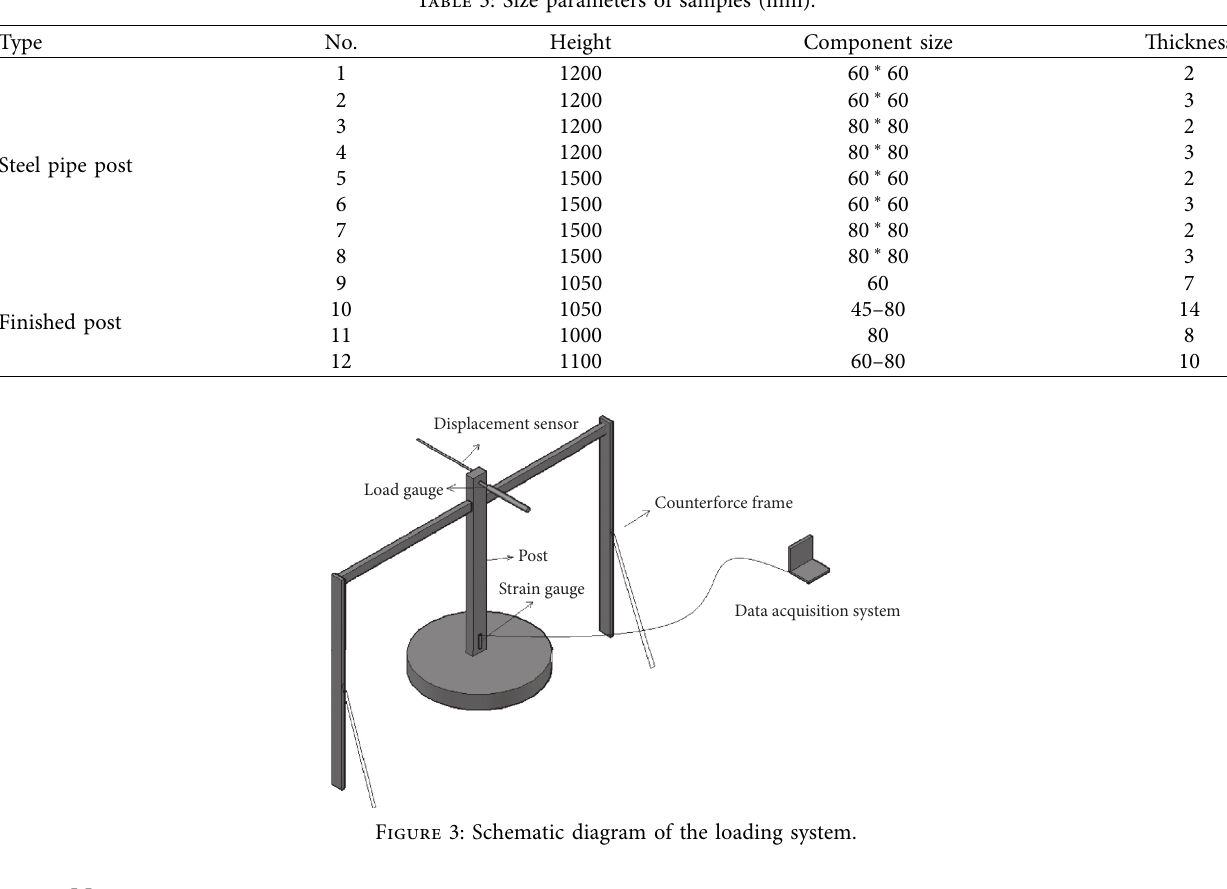
Table 3: Size parameters of samples (mm).